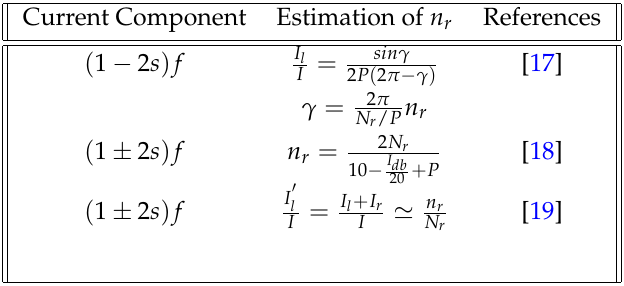
Table 5. Effect of unbalanced